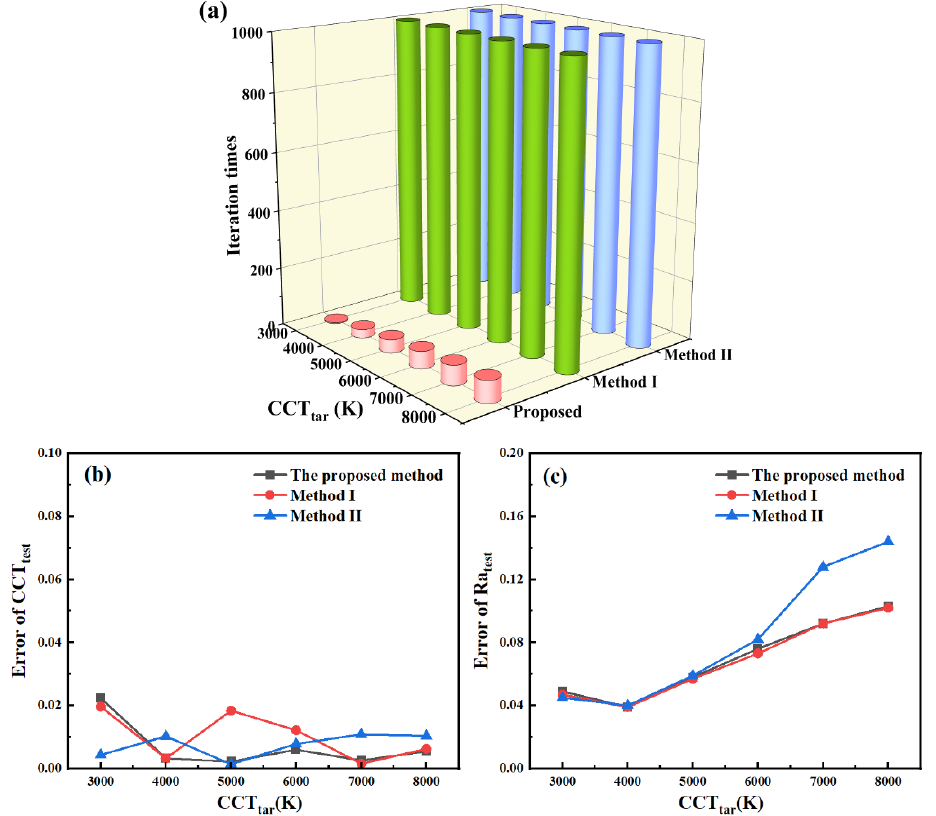
Figure 7. ( a ) Comparison between iteration times of the proposed method, method I, and method II, respectively, under different values of CCT tar ; ( b , c ) comparison between errors of CCT test and Ra test for the proposed method, method I, and method II, respectively, under different values of CCT tar .